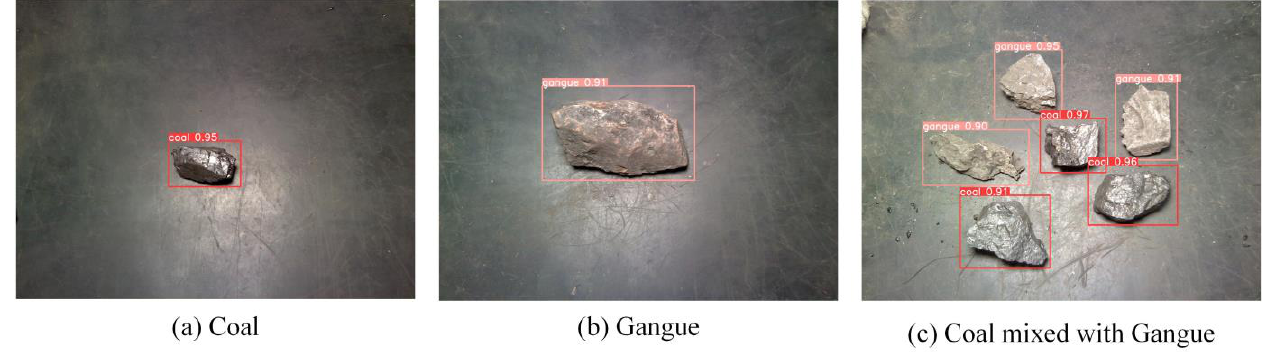
Figure 8. Detection results of improved Yolov5s. Table 3. Coordinates and score of bounding box.